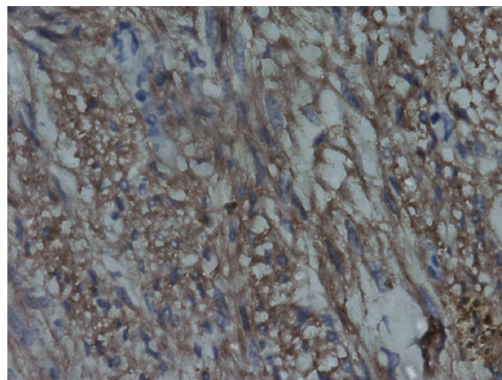
Figure 3: Photomicrograph (H&E stain; original magnification × 40) showing unremarkable overlying mucosa, submucosa, mus- cularis propria, and serosa showing infiltration by tumor.